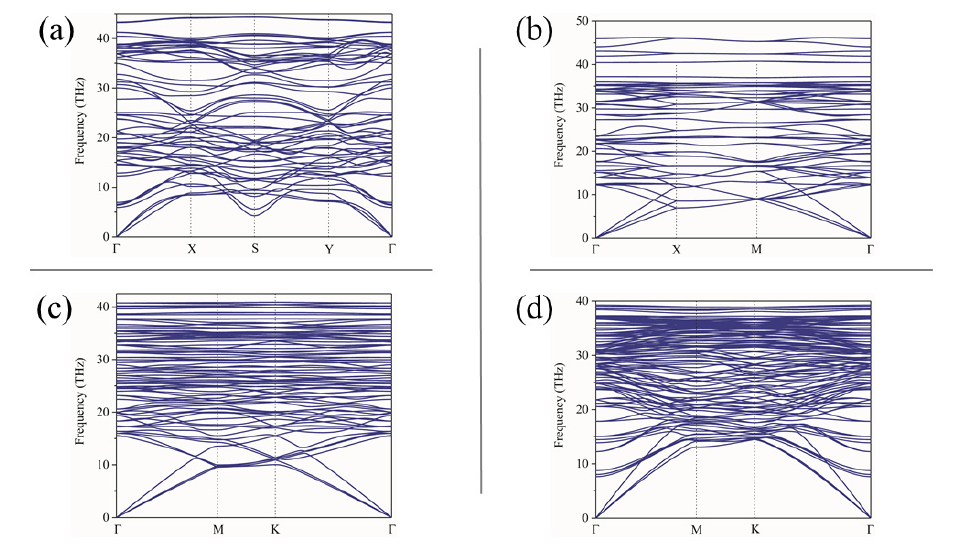
Figure 2. Phonon dispersion of ( a ) 135-3-40-C-r89-np-id355667, ( b ) 136-3-20-C-r689-np-id545421_1, ( c ) 179-3-36-C-r6789- p-id545421, ( d ) 165-3-28-C-r68-np-id545421.